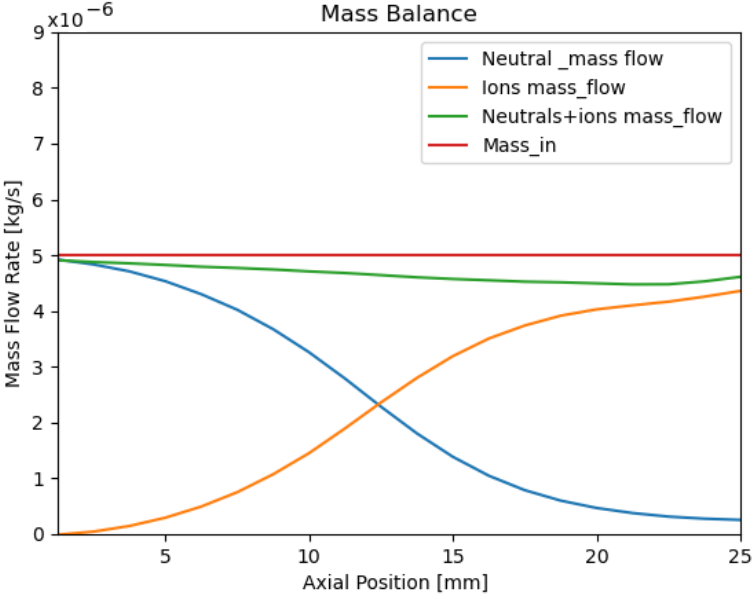
Figure 12. Test 106 Mass balance within the accelerating